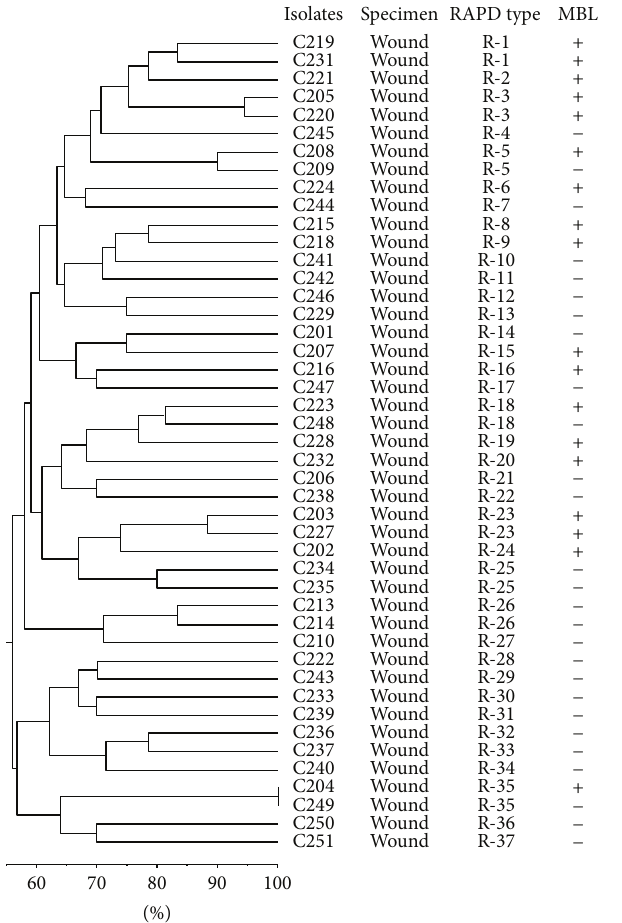
Figure 1: Dendrogram showing genetic diversity among 45 nonduplicate imipenem-resistant P. aeruginosa by RAPD-PCR.